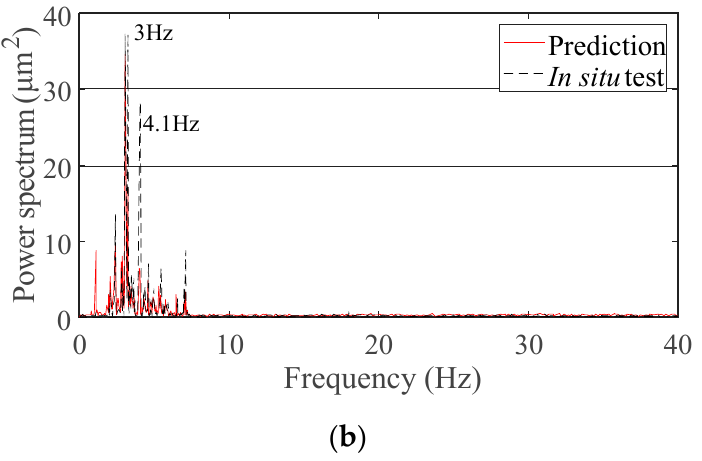
Figure 11. The signal of the prediction and the in situ measurement of T9 by using the main vibration sources as the input: ( a ) Time history curves; ( b ) and Fourier spectra.